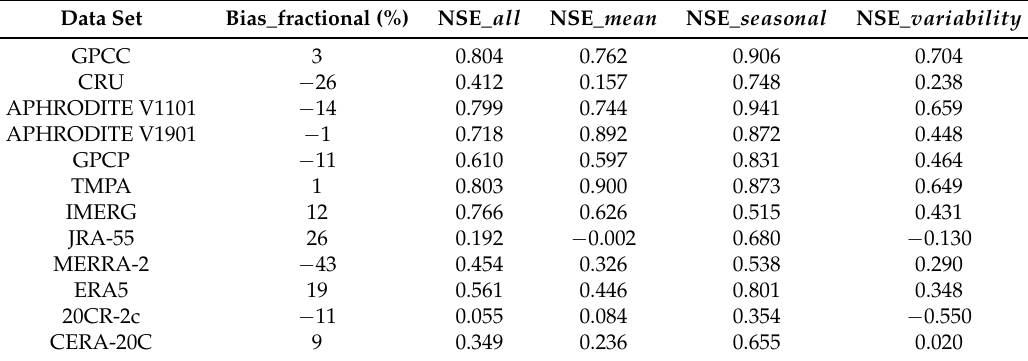
Table 2. Evaluation of precipitation data sets against station observations.